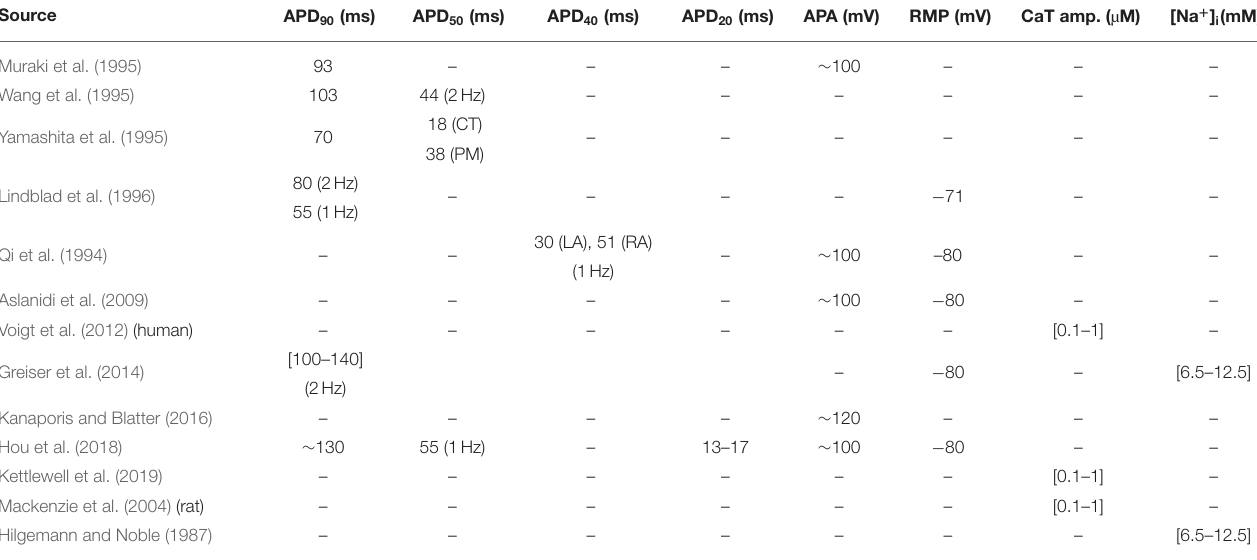
TABLE 2 | Experimental values of electrophysiological parameters obtained from literature.